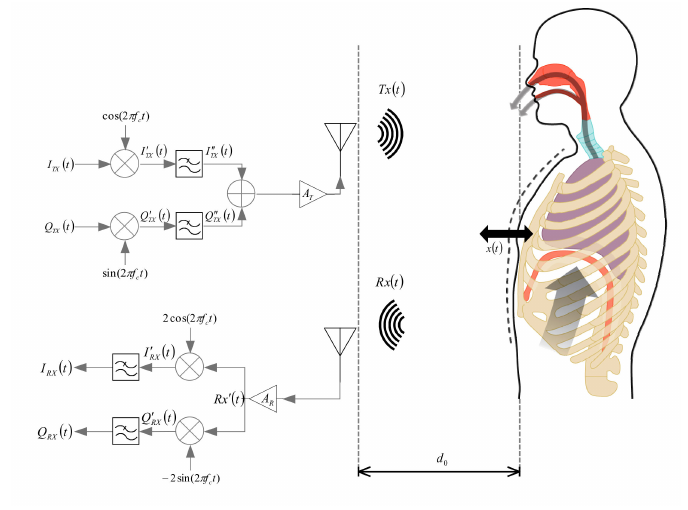
Figure 1. A continuous wave (CW) Doppler radar